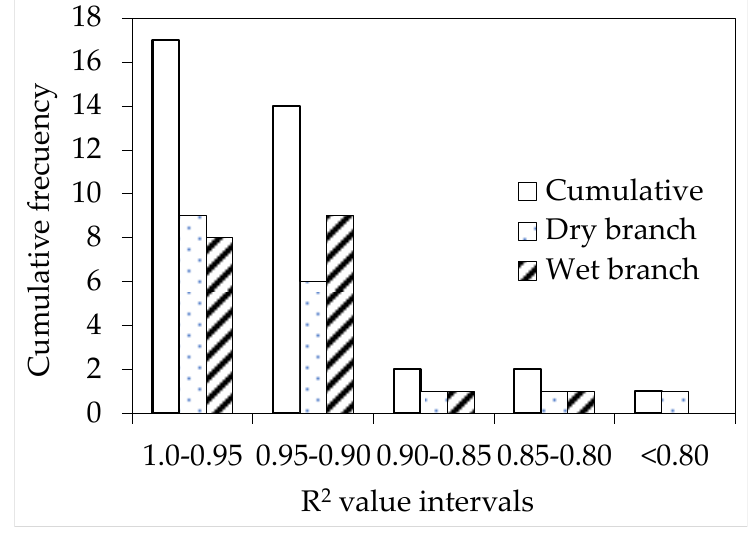
Figure 6. Cumulative frequency of R 2 values.